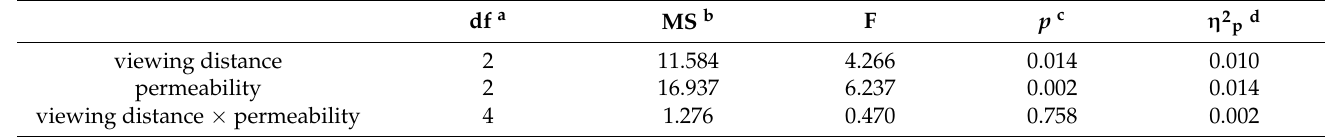
Table 14. Impacts of different viewing distances and permeability on perceived anxiety.